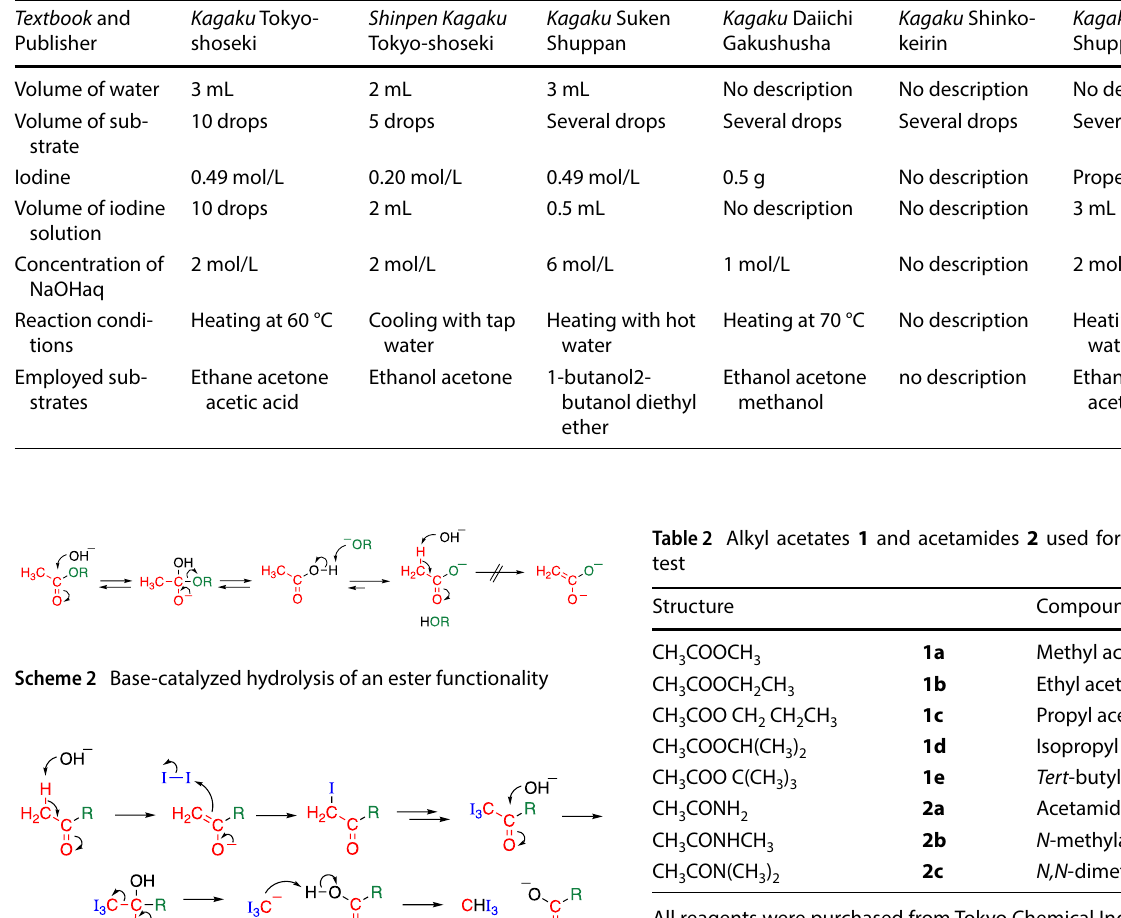
All reagents were purchased from Tokyo Chemical Industry Co., Ltd. and used without further